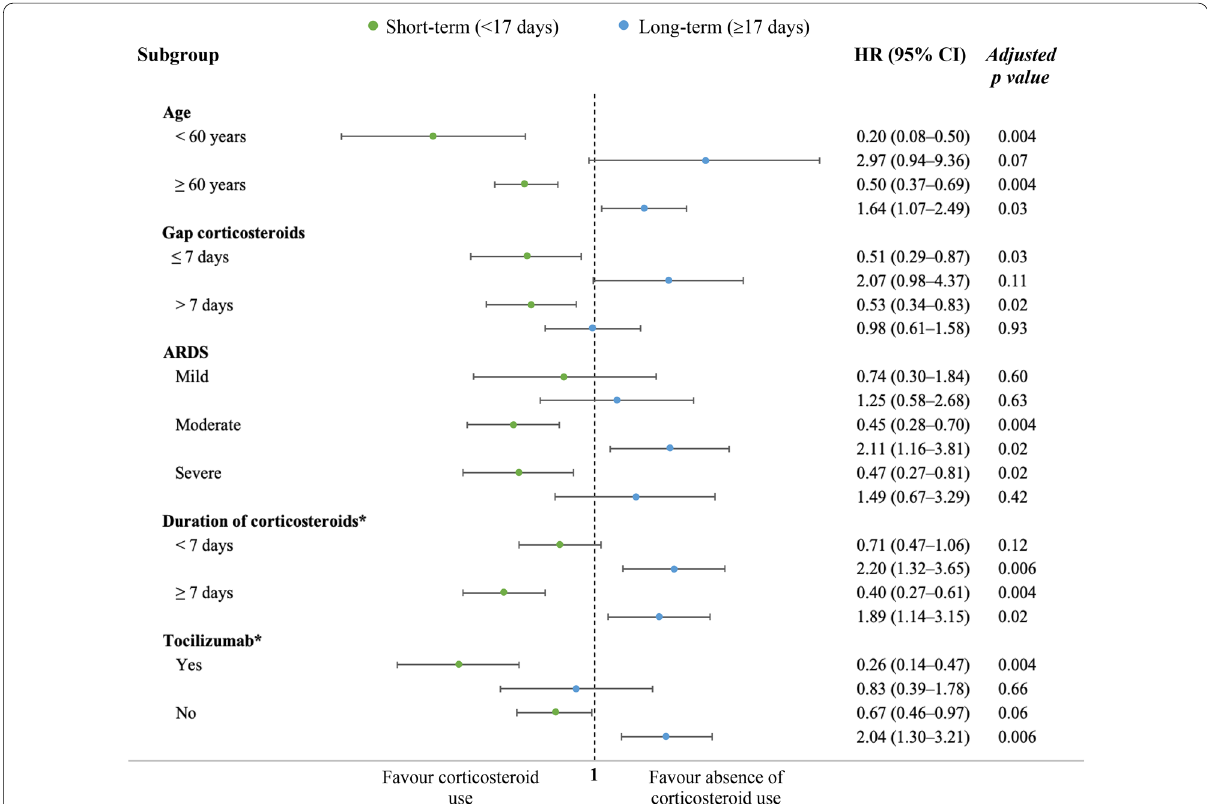
Fig. 4 Subgroup sensitivity analysis. Propensity score matching was performed for each study subgroup as in the primary analysis to evaluate the estimated effect of corticosteroids on ICU mortality over time with cause‑specific hazard model. Post hoc analysis was made for subgroups of duration of corticosteroid treatment and Tocilizumab. GAP corticosteroids mean the time (in days) since onset of symptoms to corticosteroid initiation. Models were adjusted for gender, age, body mass index, hospital GAP, ICU GAP, diagnosis GAP, shock, ACE inhibitors, ARBs, Comorbidity, asthma, COPD, chronic kidney disease, haematological disease, diabetes mellitus, neuromuscular disease, autoimmune disease, ischaemic heart disease, hypertension, immunosuppression, dyslipidaemia, hypothyroidism, APACHE II, SOFA, pulmonary infiltrates, lactate dehydrogenase, white blood cells count, creatinine, urea, C‑reactive protein, procalcitonin, Lactate, d ‑dimer, antibiotics, oseltamivir, lopinavir plus ritonavir, remdesivir, interferon, hydroxychloroquine, Tocilizumab, bacterial co‑infection, ARDS severity, fractional of inspired oxygen (FiO 2 ), positive end‑expiratory pressure, tidal volume, partial pressure of carbon dioxide, pH, RIFLE criteria, myocardial dysfunction and corticosteroid treatment (short and long‑term). ICU intensive care unit, ACE angiotensin‑converting enzyme, ARBs angiotensin receptor blockers, COPD chronic obstructive pulmonary disease, APACHE acute physiology and chronic health evaluation, SOFA sequential organ failure assessment, ARDS acute respiratory distress syndrome, CRP C‑reactive